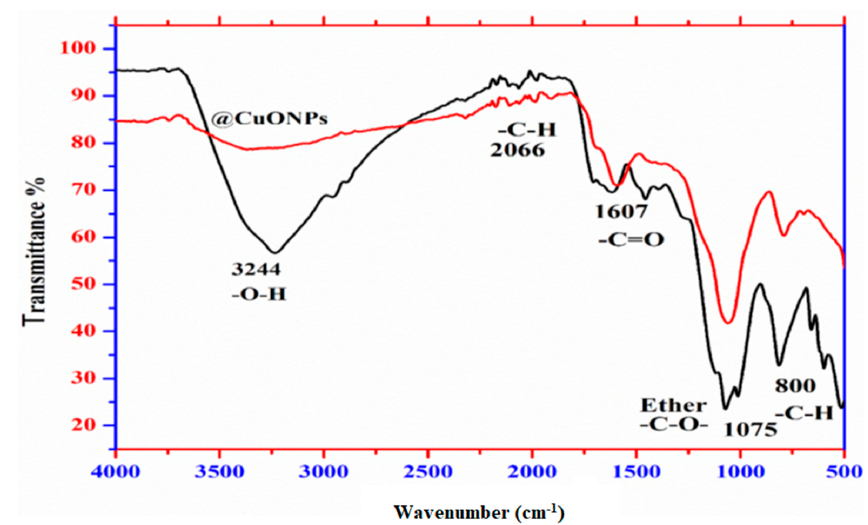
Figure 2. The FTIR spectrum of CuONPs.